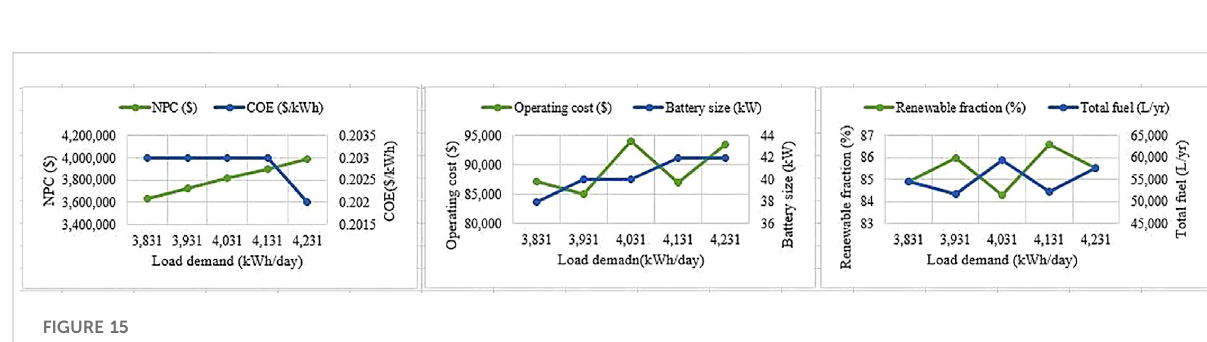
FIGURE 15 Effect of load demand variation of charge on the selected dependent